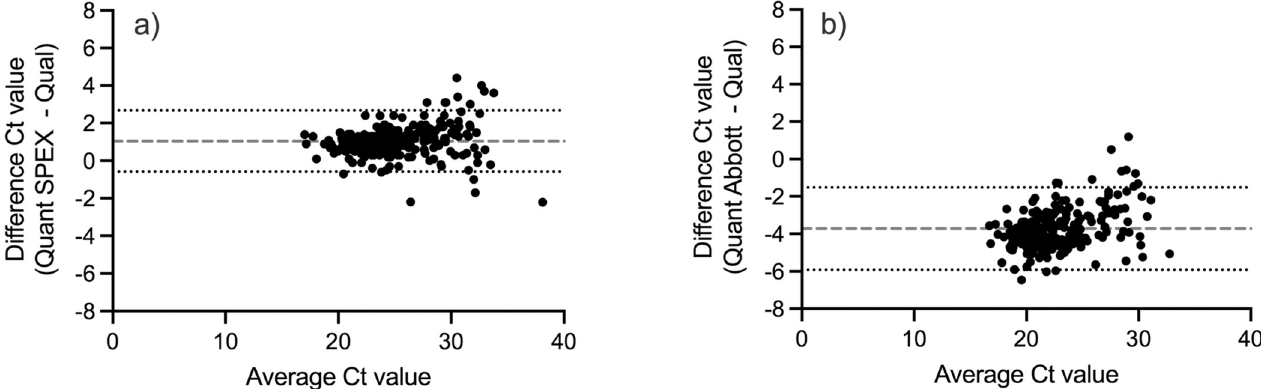
Fig 1. Bland-Altman analysis of quantitative Roche SPEX (a) and quantitative Abbott (b) compared to the qualitative assay.